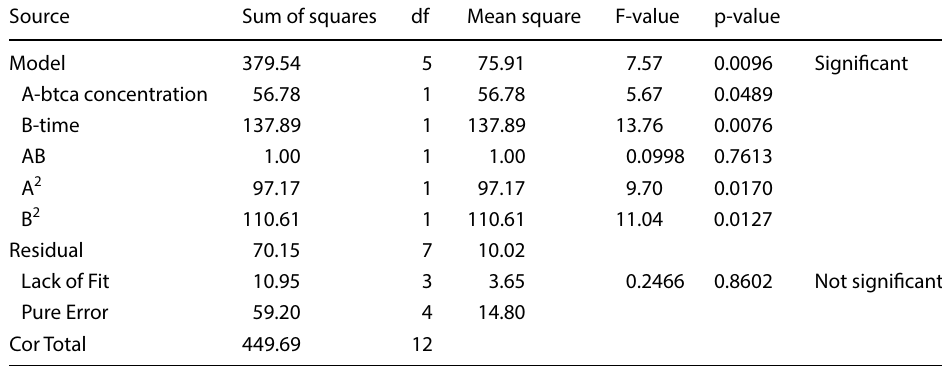
Table 2 ANOVA analysis of esterification